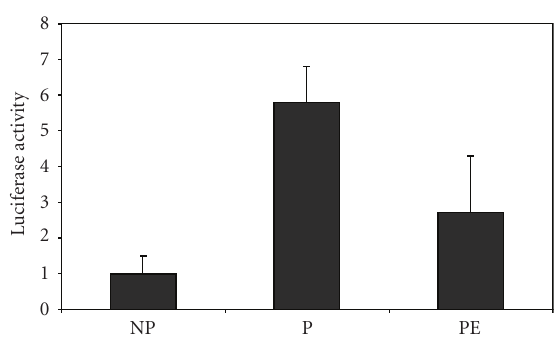
Figure 1: JEG-3 cells were transfected with PPRE-luciferase re- porter vectors and treated with pooled sera (10%) from non- pregnant (NP), pregnant (P) and preeclamptic (PE) women. Lu- ciferase acitivity, relative to cells treated with 10% dextran charcoal- shipped fetal calf serum (DCSS), is reported on the ordinate.